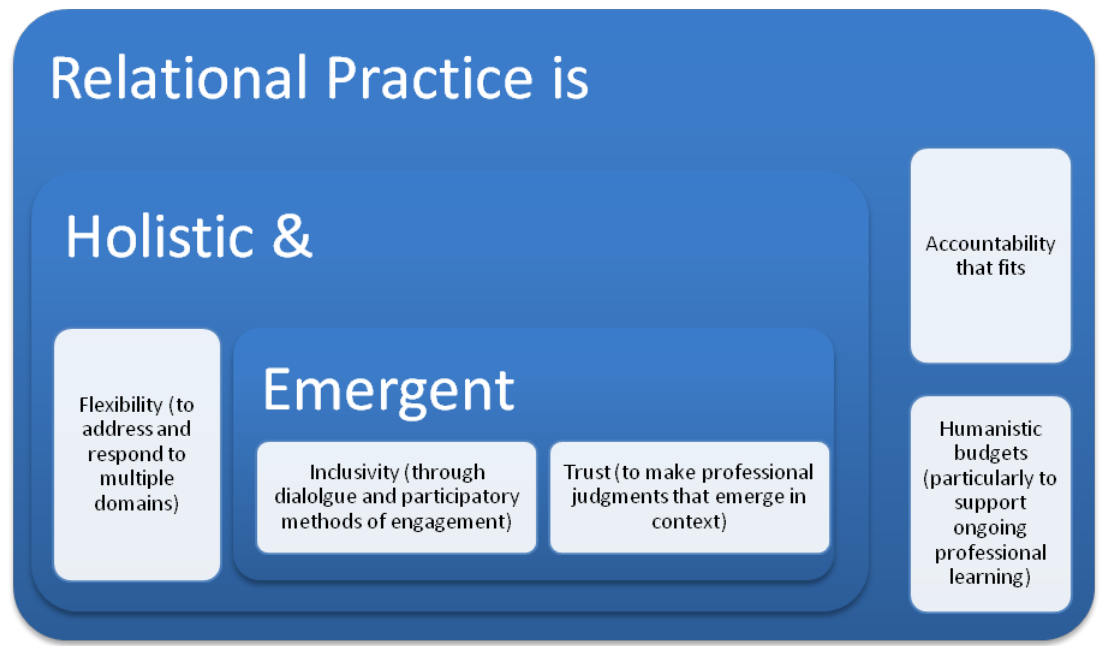
System factors to support youthwork as a relational